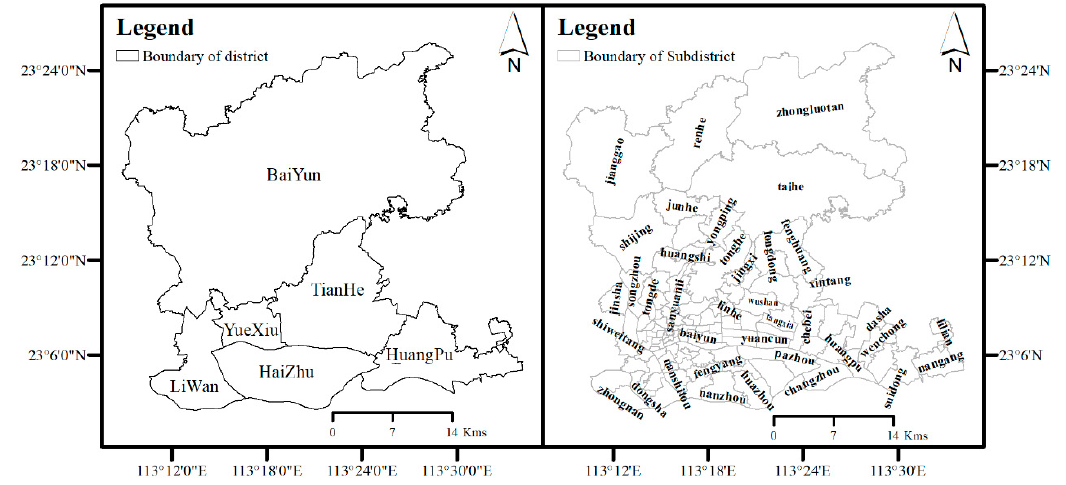
Figure 1. Map of the study area in Guangzhou,